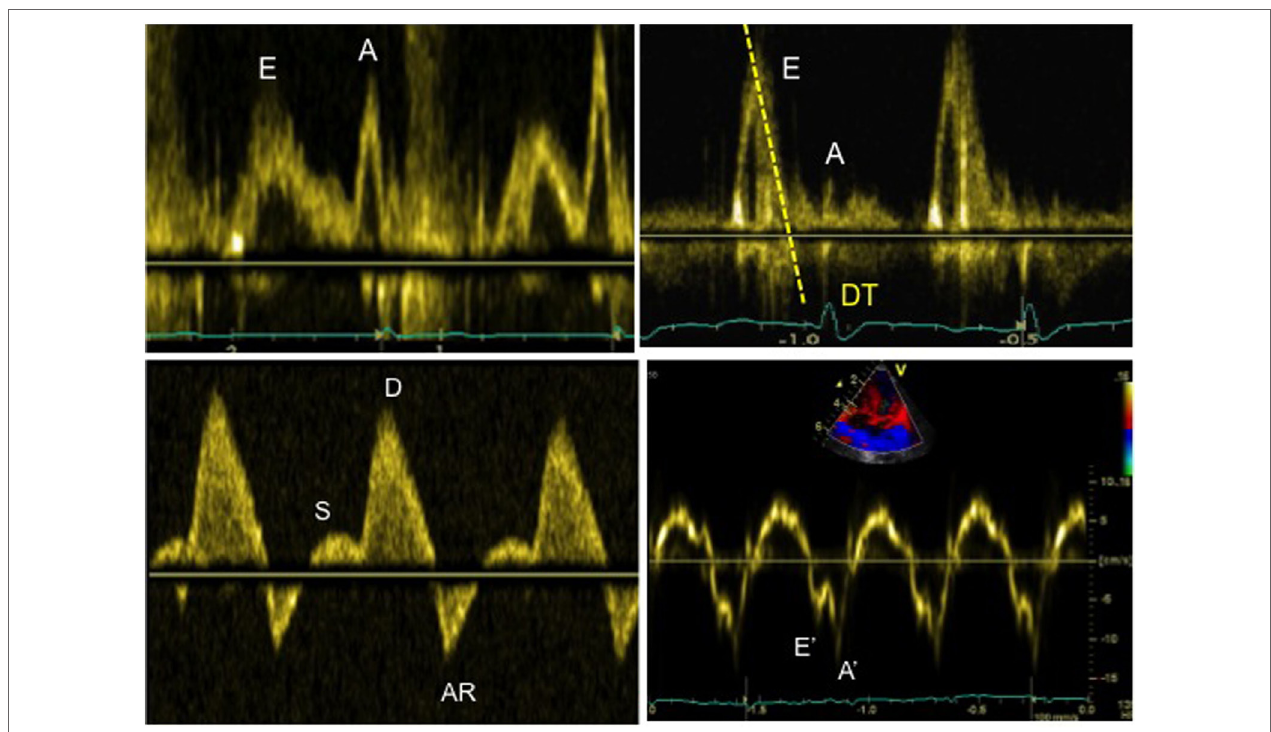
FigURe 7 | Evaluation of diastolic function in a patient with severe diastolic dysfunction: (1) mitral inflow Doppler pattern with E and A wave reversal (above left image); (2) mitral inflow Doppler pattern with sharp E wave DT (above right image); (3) pulmonary venous Doppler with prominent diastolic flow, S/D reversal and increased velocity of AR wave (below left image); (4) TDI at the mitral annulus with E ′ /A ′ reversal and decreased E ′ wave velocity < 8 cm/s (below right